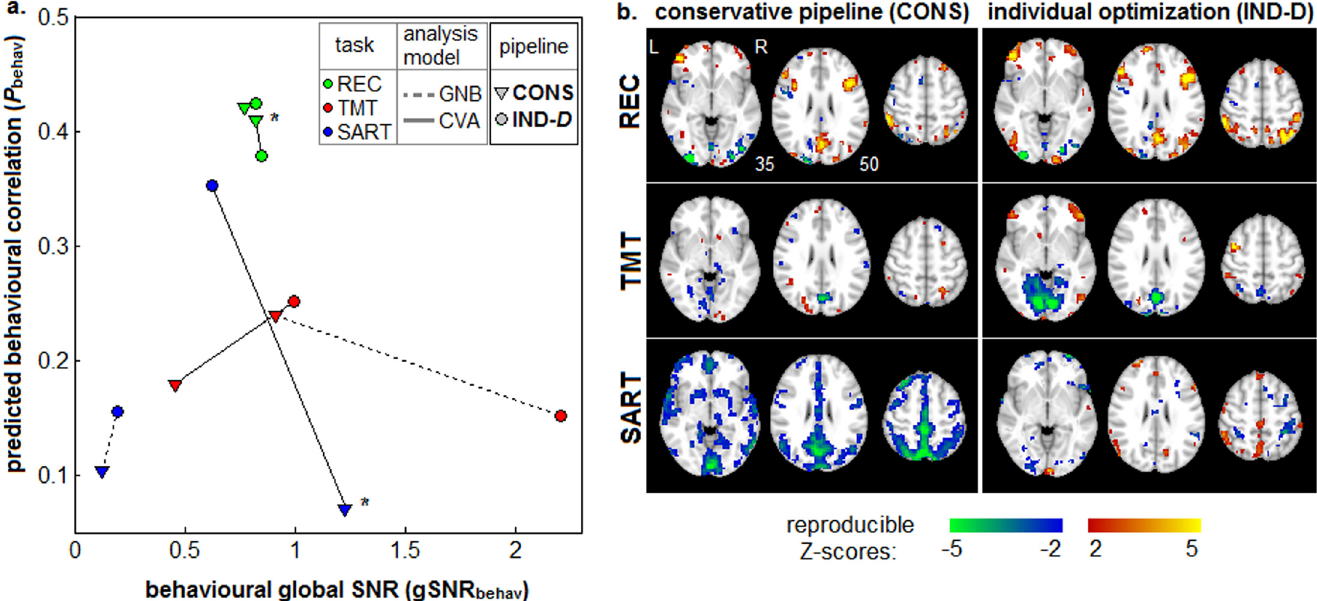
Fig 6. Change in behavioural correlation and global Signal to Noise Ratio for individual subject optimization. (a) global Signal-to-Noise Ratio (gSNR behav ) vs. behavioural correlations ( ρ behav ), for Partial Least Squares (PLS) analysis of the correlation between SPM activation and behavioural performance. Results are shown for three tasks: Recognition (REC), Trail-Making Test (TMT) and Sustained Attention to Response Task (SART). We also plot results for two analysis models: univariate GNB and multivariate CVA. For each task/analysis model, we plot a line connecting (gSNR behav , ρ behav ) from the standard conservative pipeline (CONS) to the individually optimized one (IND-D). IND-D optimization significantly improves gSNR behav in all cases (p < 0.01), and significantly improves ρ behav in all cases except TMT+GNB (marked with a ‘ * ’ ) at p (cid:1) 0.03 (see METHDODS : Validation 2 : Behavioural Testing ). (b) Z-scored SPMs showing brain regions that are most correlated with behavioural performance in PLS analysis, for all tasks and both pipelines, for the CVA